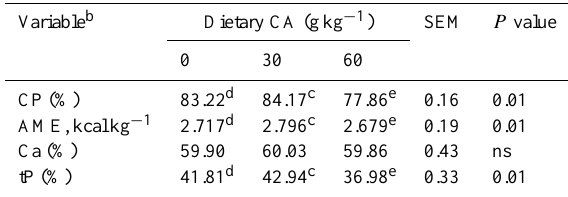
a Each value represents the mean of 15 observations (five replicates × 3 birds per replicate). b CP, crude protein; AME, apparent metabolisable energy; tP, total phosphorus. c − e Mean values within a column with no common superscript differ significantly from each other ( P <0.05); ns, not significant.